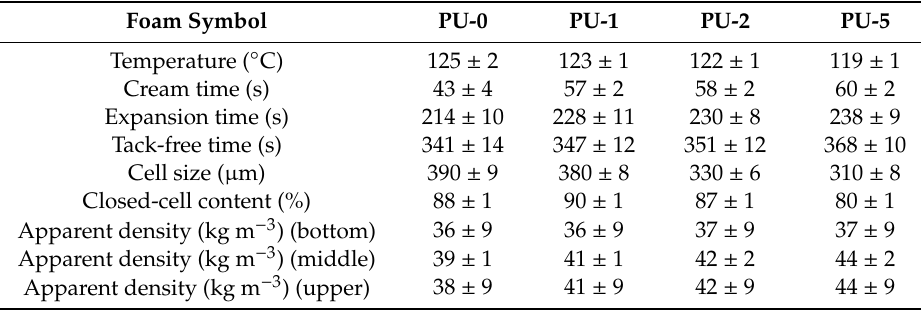
Table 3. Selected properties of PU composite foams.